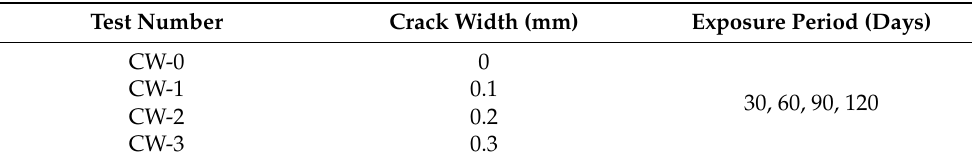
Figure 1. Schematic view of the specimen used for the analysis. ( a ) Specimen used for immersion ( b ) specimen cut in half for the measurements ( c ) slices used for free chloride content test. Table 3. Test configurations.